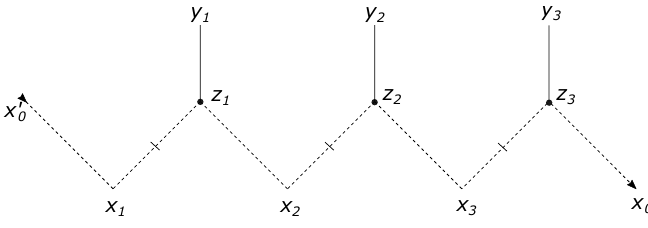
Figure 12 . Graphic representation of the integral kernel stand for scalar propagators 1 / ( z the dashed lines with a bar stand for ( ¯ σ µ ( x − z ) matrices σ , ¯ σ in the product.